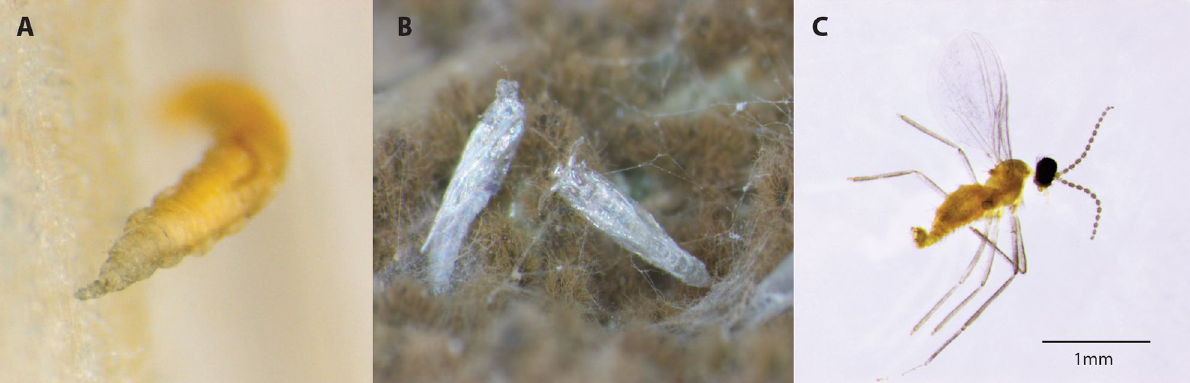
Figure 1. Larva ( A ) 12 , pupal case ( B ), and an adult male ( C ) of Asynapta groverae.